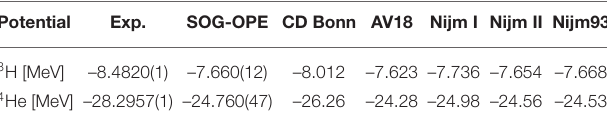
TABLE 12 | 3N and 4N binding energies for various NN potentials using the Faddeev equations for 3 H and the Yakubovsky equations for 4 He respectively [25,